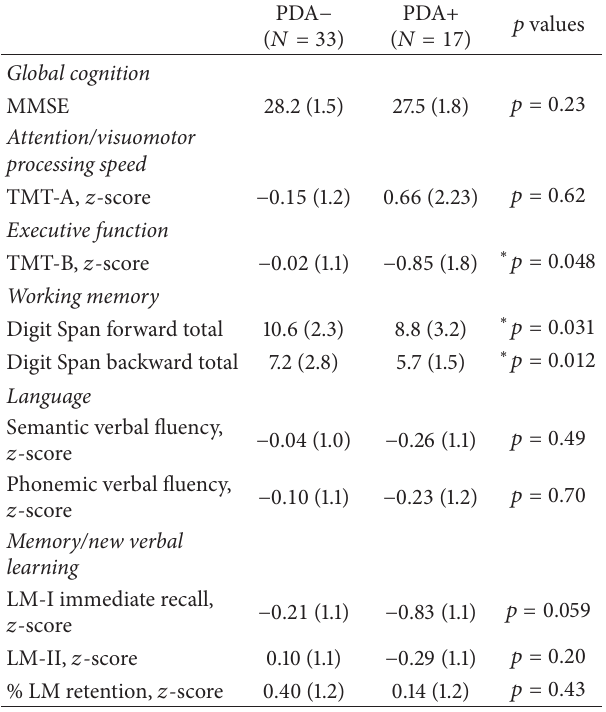
Table 2: Neuropsychological performance.